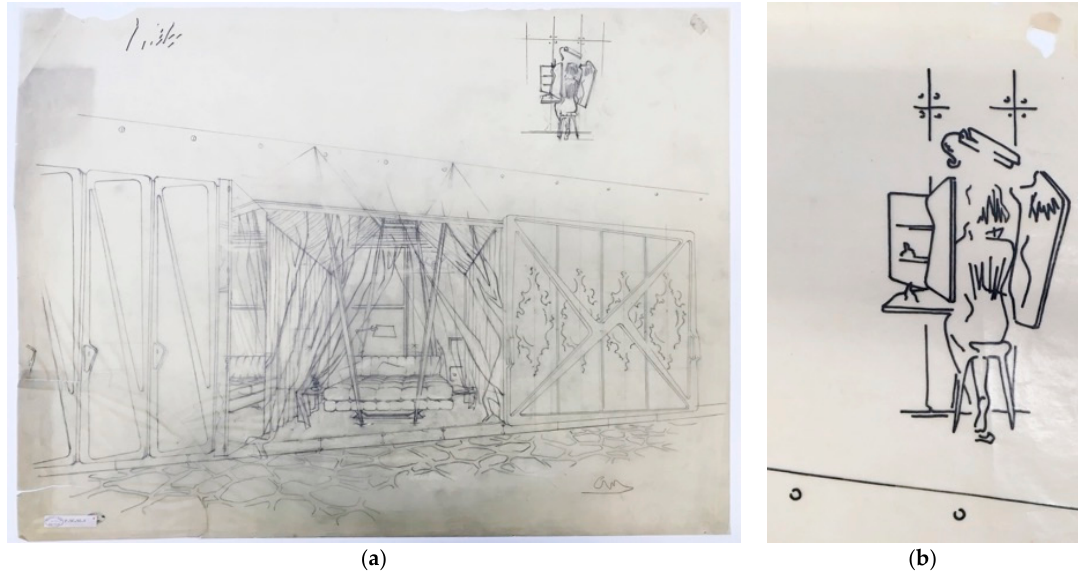
Figure 4. ( a ) ACM P.9C.92: Pencil drawing of the perspective from the gallery, with sketch of lady silhouette in the upper margin; ( b ) ACM P.9C.92.8: Detail of lady figure in the final ink